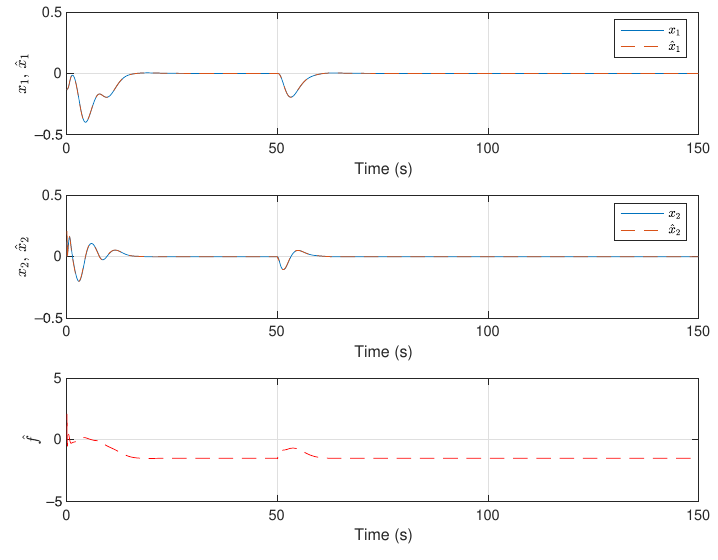
Figure 8. Observed results of LESO for variable altitude